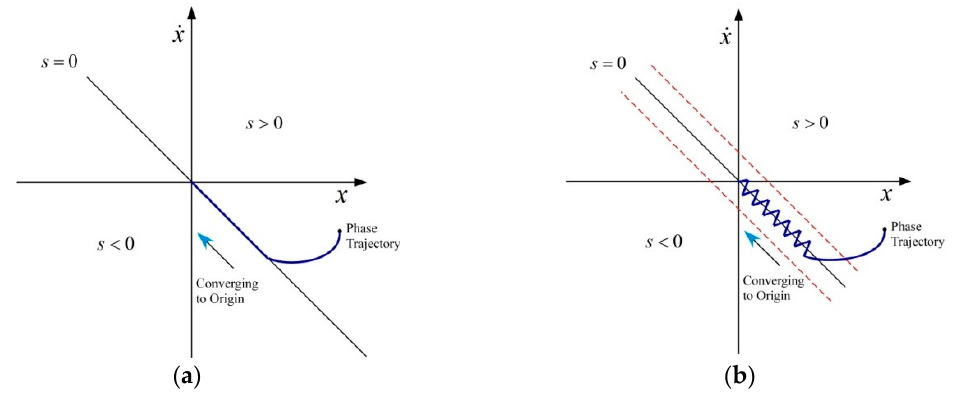
Figure 3. Phase trajectory in sliding mode: ( a ) ideal sliding mode; and ( b ) real sliding mode.